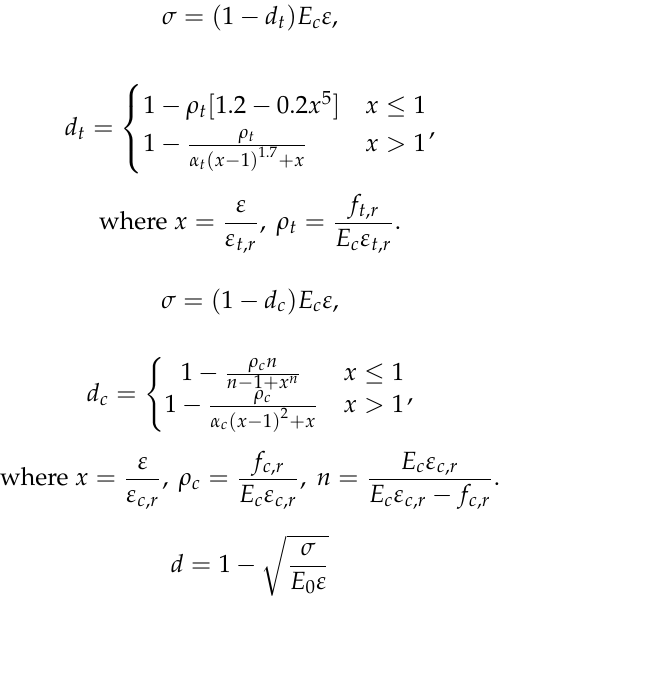
Table 1. Results of sensitivity analysis.